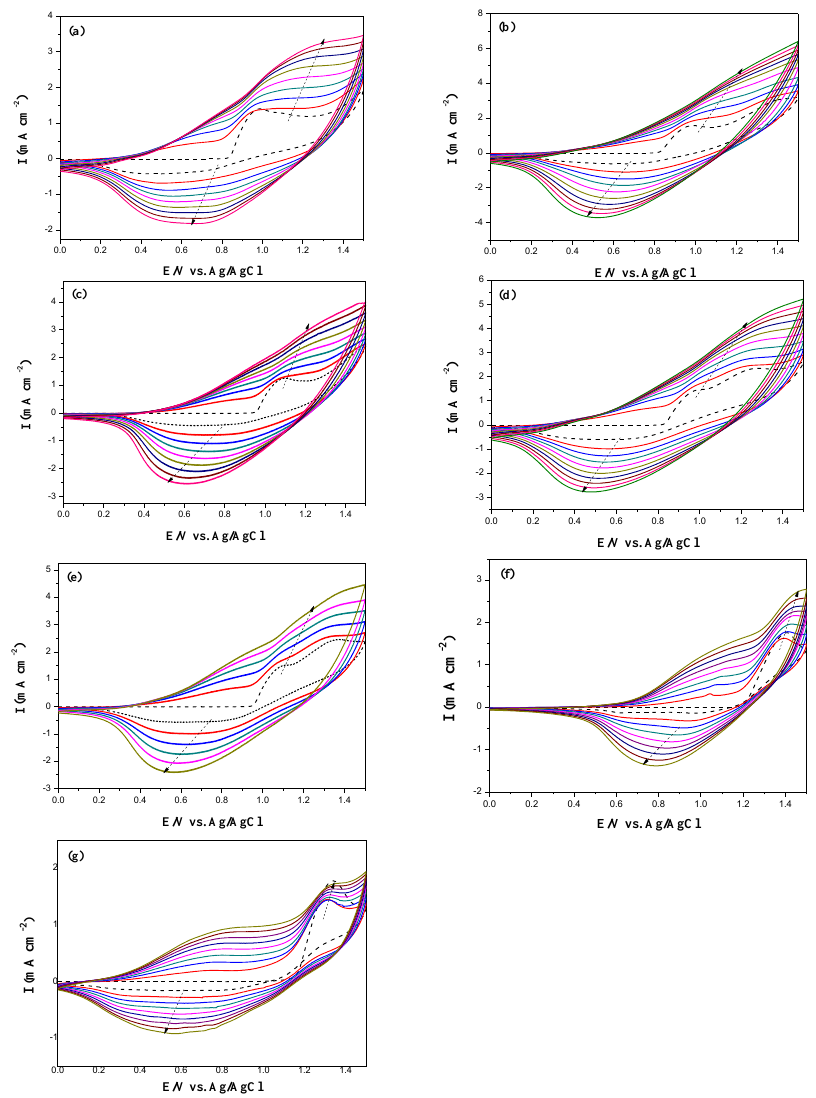
Figure 2. Electrochemical synthesis of ( a ) a homopolymer (PDTC), ( b ) P(DTC- co -BTP), ( c ) P(DTC- co -BTP2), ( d ) P(DTC- co -TF), ( e ) P(DTC- co -TF2), ( f ) PBTP, and ( g ) PTF in ACN solution at 100 mV s − 1 on an ITO electrode.